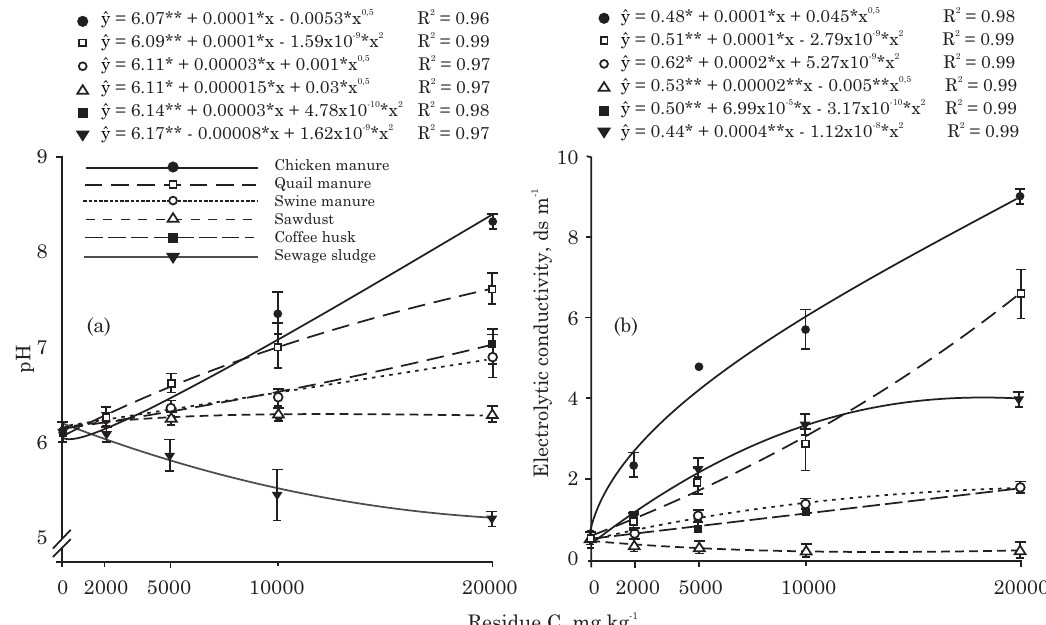
Figure 1. Soil pH (a) and EC (b) in response to increasing C levels in organic